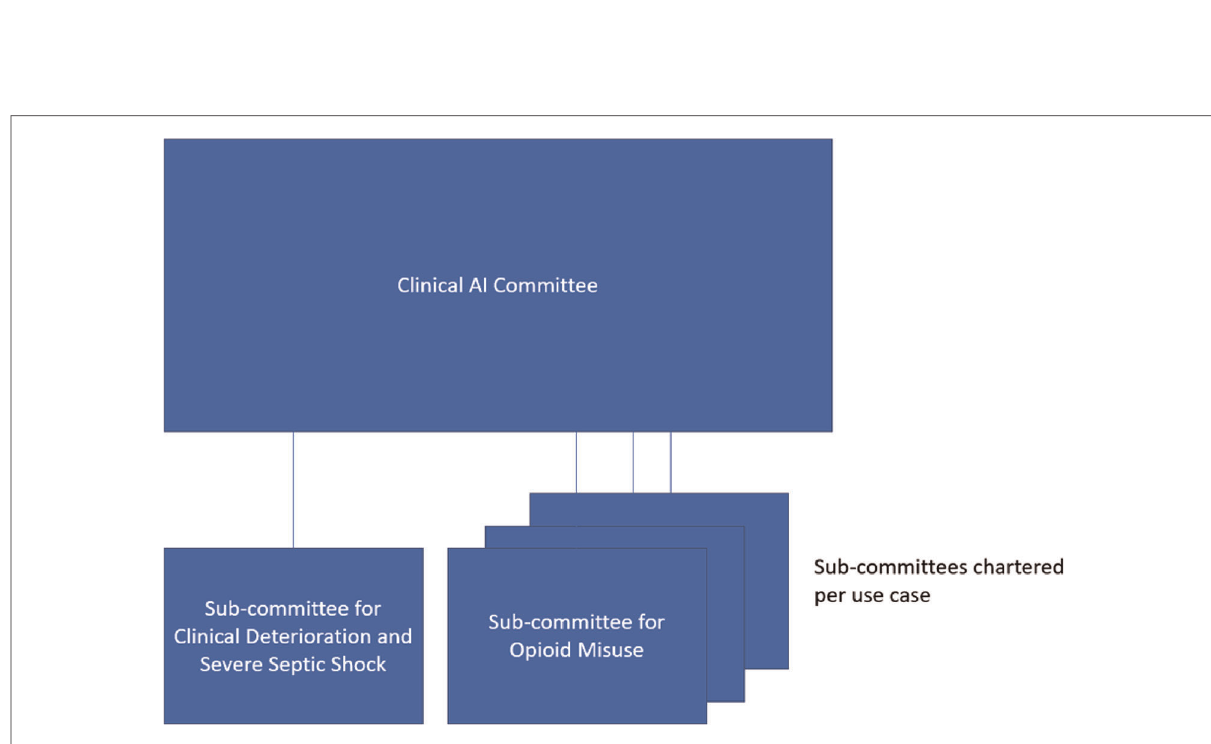
FIGURE 2 Clinical AI and predictive analytics committee and